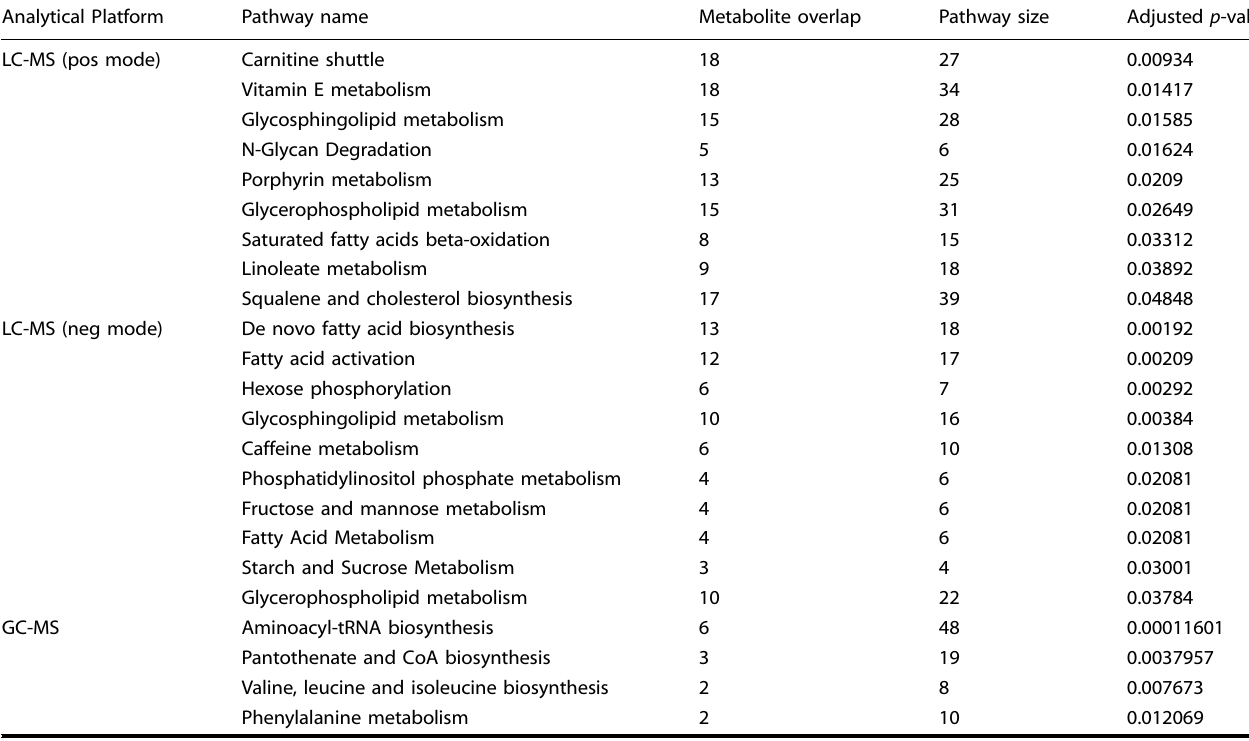
Table 3. Results from pathway analysis. Analytical